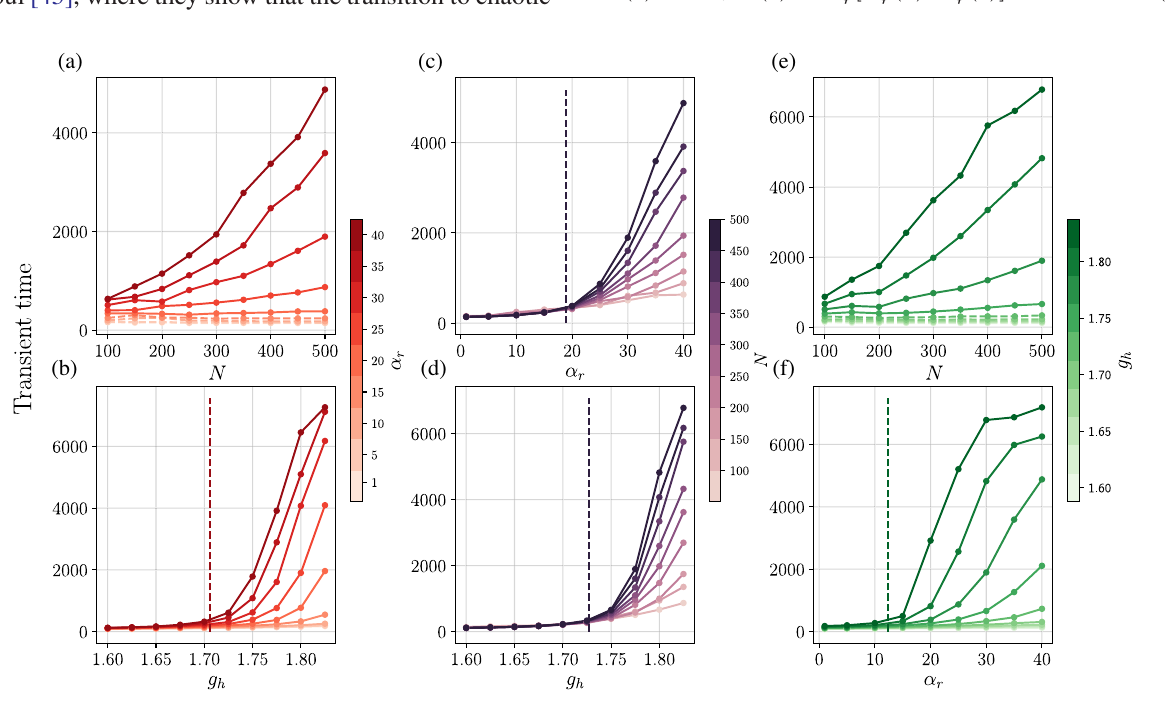
, relative to τ ) as a function of g , α , and system size N . T h h r < α (cid:3) ð g h Þ . Dashed vertical lines are critical values of α r or g h . (a) τ T vs N for r r; DMFT such that α (cid:3) ð g h Þ ¼ 40 . (c) τ T vs α r for g h ¼ 1 . 775 ; the h r; DMFT ð g h Þ ¼ 30 . (e) τ T vs N for α r ¼ 30 ; r; DMFT ð g h Þ . (f) τ T vs α r for N ¼ 500 ; the dashed vertical line is α (cid:3) ð 1 . 85 Þ . r; DMFT r; DMFT